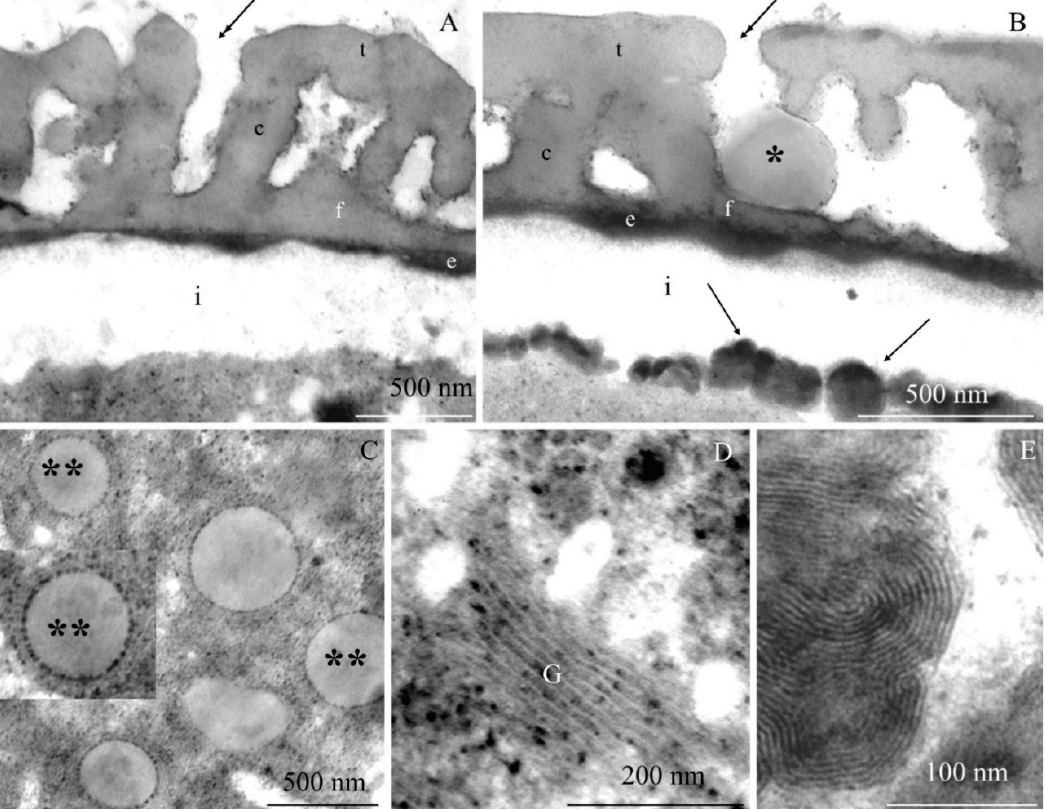
Figure 8. A – E . Fragments of pollen grains in R. idaeus ‘Laszka’: ( A , B) —perforated tectum (t), visible perforations (double-headed arrow), columellae (c), pollenkitt (asterisk), foot layer (f), endoexine (e), numerous electron-dense structures (arrow) located at the intine (i); ( C )—electron-dense cytoplasm with numerous plastoglobules (two asterisks); ( D )—Golgi apparatus (G); ( E )—concentric lamellar system of electron-dense structures marked with arrows in photo. B. A — E – TEM.